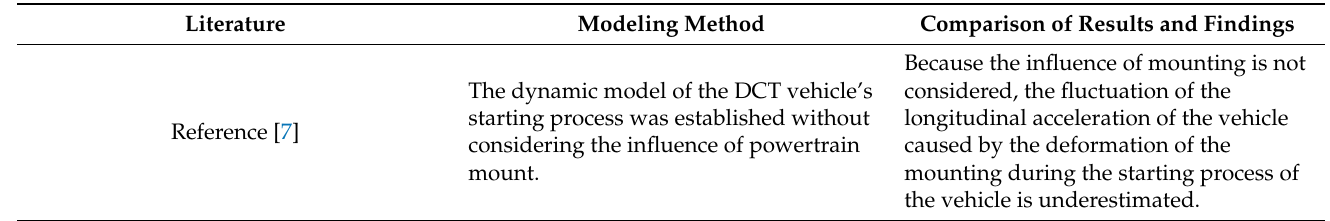
Table A3. The innovation of this paper and its comparison with existing important